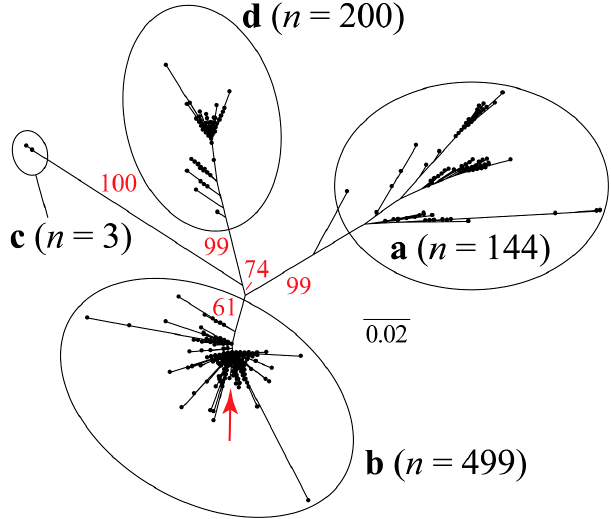
Figure 1. Unrooted maximum likelihood tree based on 705 bp of the porcine circovirus type 2 (PCV2) capsid gene. The red arrow shows the approximate phylogenetic position of the sequence that was recovered in Rancangua in 2007. The genotype classification (a, b, c, and d) follows Franzo et al . (2015)[37] (Supplementary Material, Table S1). In red, the bootstrap values based on 1000 replicates are indicated for the main internal branches.